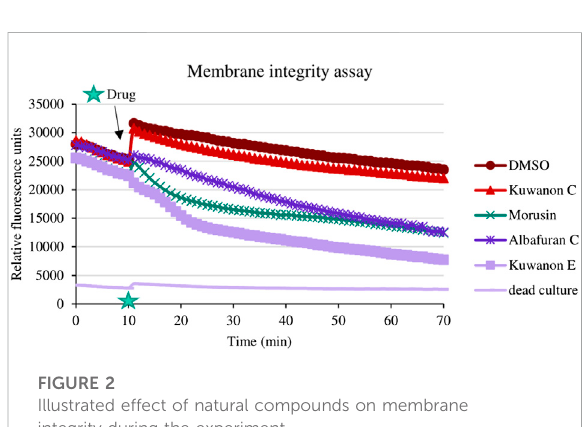
FIGURE 2 Illustrated effect of natural compounds on membrane integrity during the experiment.